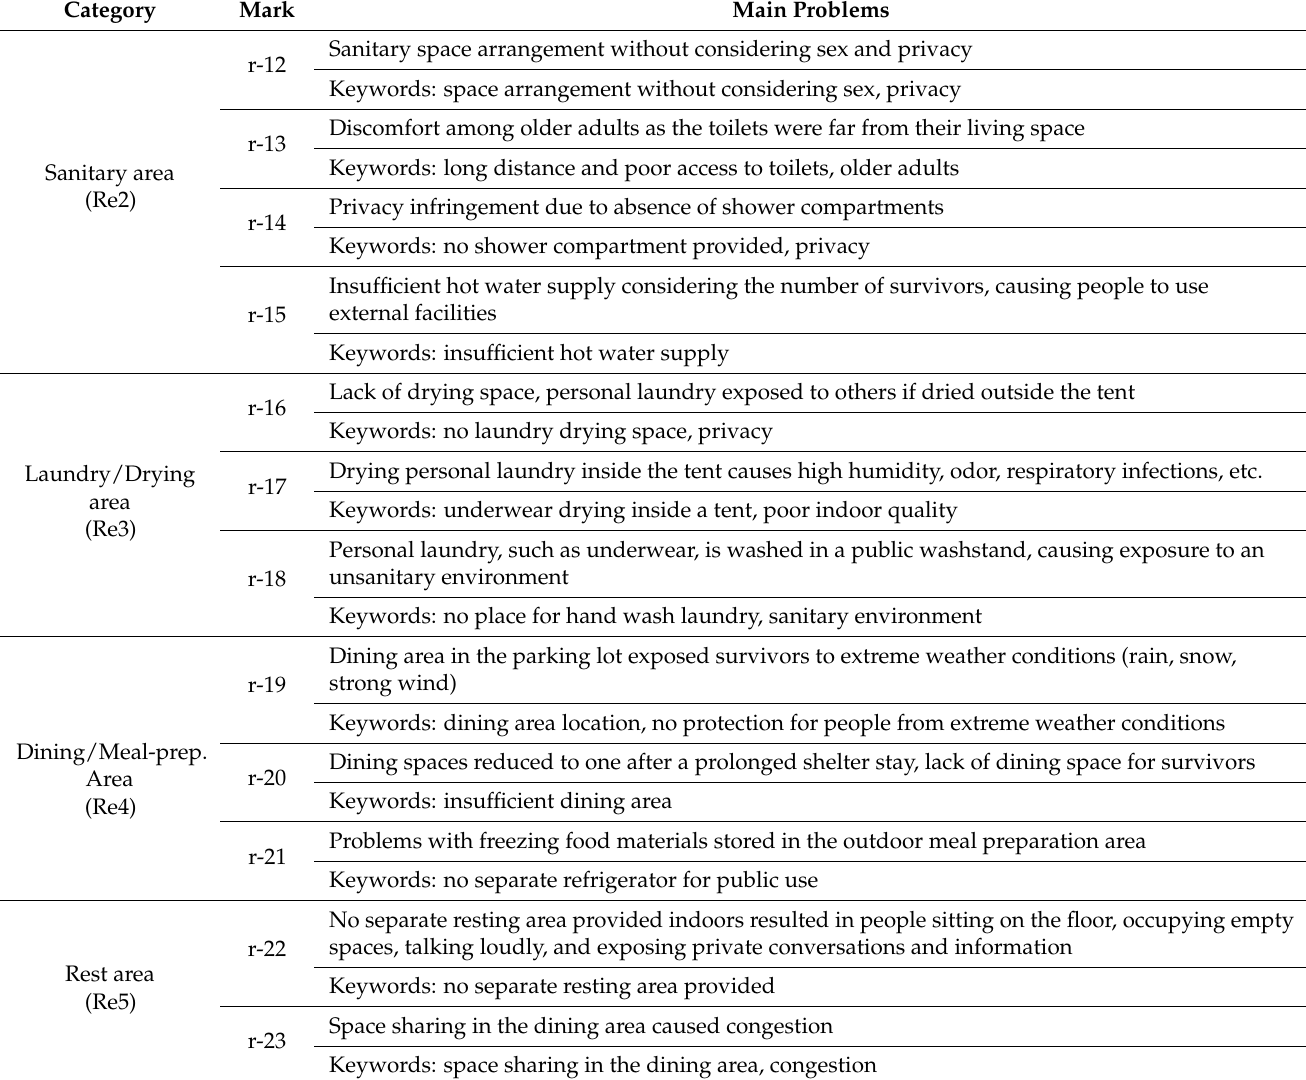
Table 6. Habitability problems identified in the residential zone